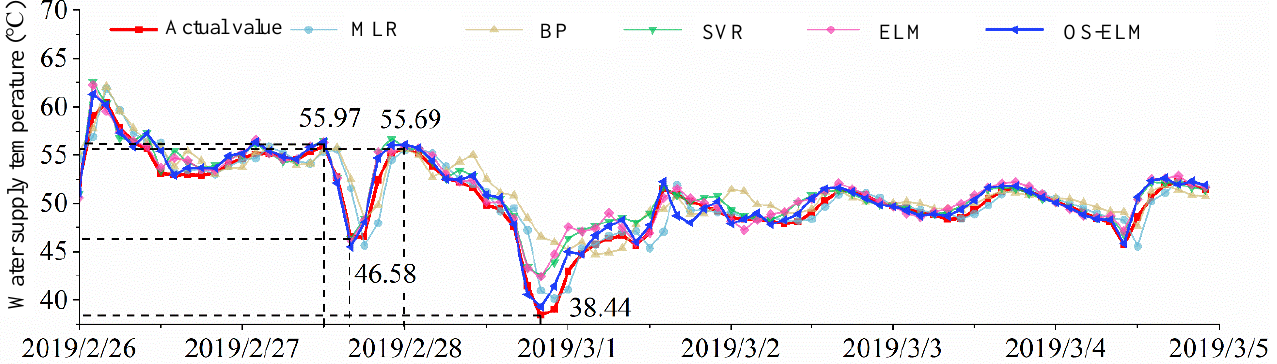
Figure 9. Comparison of the predicted values and actual values of the five models on feature set M. The comparison of the relative errors of the five prediction models is shown in Figure 10. It can be seen from Figure 10 that, for 26 February and 1–4 March, the prediction relative errors of the five models remain within ± 5%, meeting the error requirements. For 27 February, the absolute maximum relative errors of the MLR, BP neural network, SVR and ELM models are 10.69%, 12.26%, 5.58% and 5.52%, respectively, while the relative errors of the OS-ELM model remain within ± 5%. For 28 February, the predicted values of MLR, BP neural network, SVR and ELM fluctuate greatly compared with the actual values, and the maximum relative errors are 13.86%, 21.23%, 12.46% and 14.63%, respectively, while the maximum relative error of the OS-ELM model is 6.20%. When the water-supply temperatures of the secondary network fluctuate greatly, the prediction accuracy of the OS-ELM model is higher than that of the other four models.